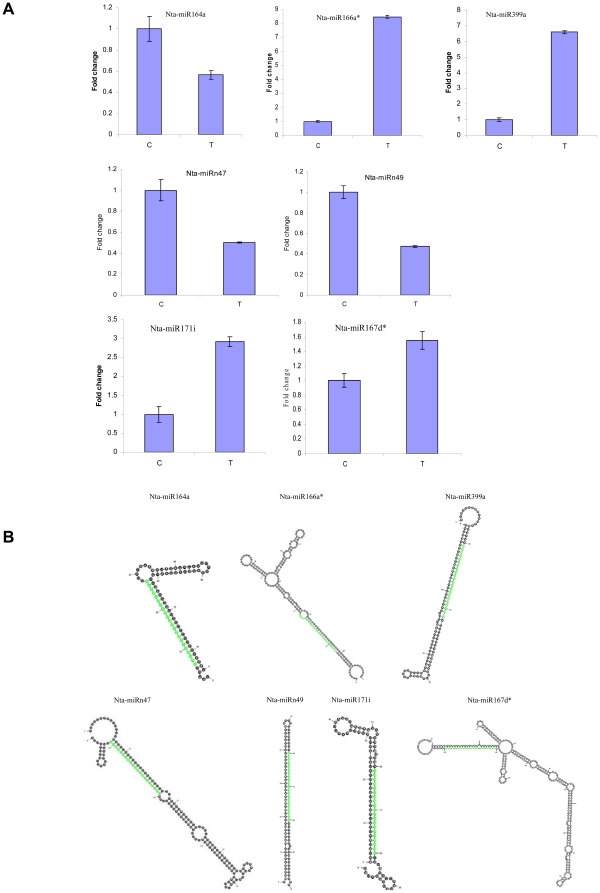
Validation of some miRNAs in tobacco roots.
A: QPCR products of miRNA. (C, before topping. T, after topping. Error bars indicate one standard deviation of three different biological replicates (n  =  3)). B: Predicted hairpin structures of miRNA precursors. (Mature miRNA positions were highlighted in green color.).